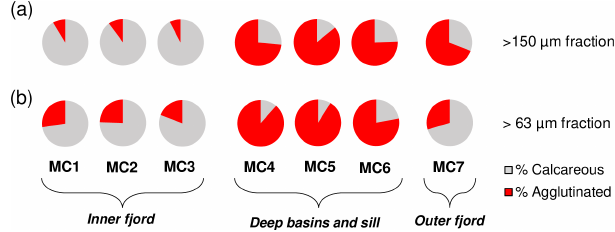
Figure 8. Relative abundances of calcareous foraminifera (in grey) and agglutinated foraminifera (in red) considering the > 150µm size fraction (a) and the > 63µm size fraction (b)